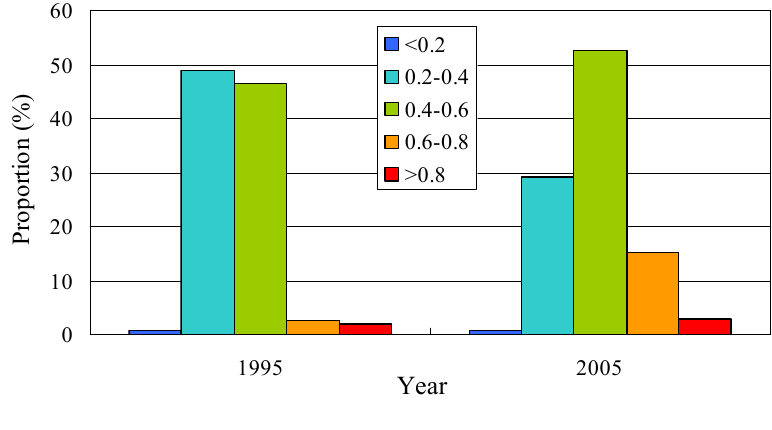
Figure 6. Proportion of area of land use eco-risk degree at different grade levels.